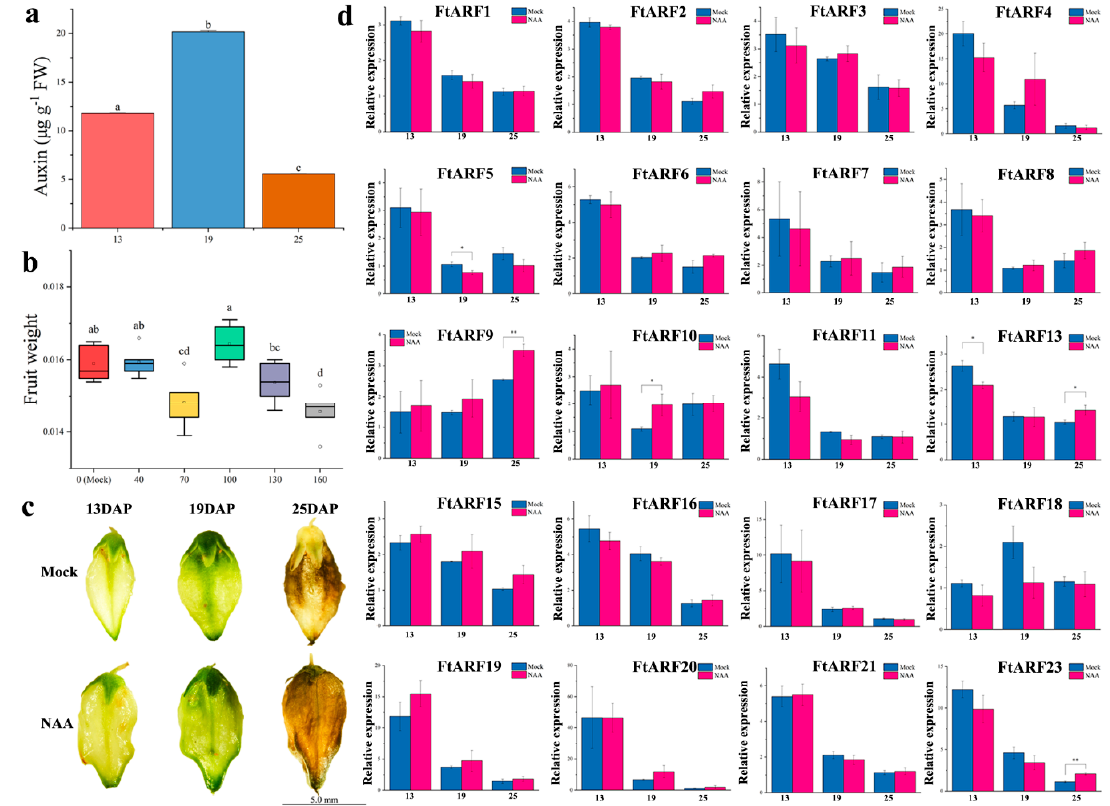
Figure 6. Fruit development of tartary buckwheat under exogenous auxin treatment. ( a ) IAA content during fruit development. ( b ) Final weight of the fruits treated with different concentrations of exogenous auxin. x-axis: weight of mature fruit, y-axis: concentration of naphthalene acetic acid treatment. ( c ) Pictures of the fruits treated with exogenous auxin during fruit development. ( d ) Differences in the expression of 20 FtARF genes under exogenous auxin treatment during fruit development. Mock: the same amount of water treatment, NAA: 100 mg · L − 1 naphthalene acetic acid treatment. Error bars were obtained from three measurements. Small letter(s) above the bars indicate significant differences ( α = 0.05, LSD) among the treatments. * and ** indicate significant correlation at 0.05 and 0.01 levels, respectively.